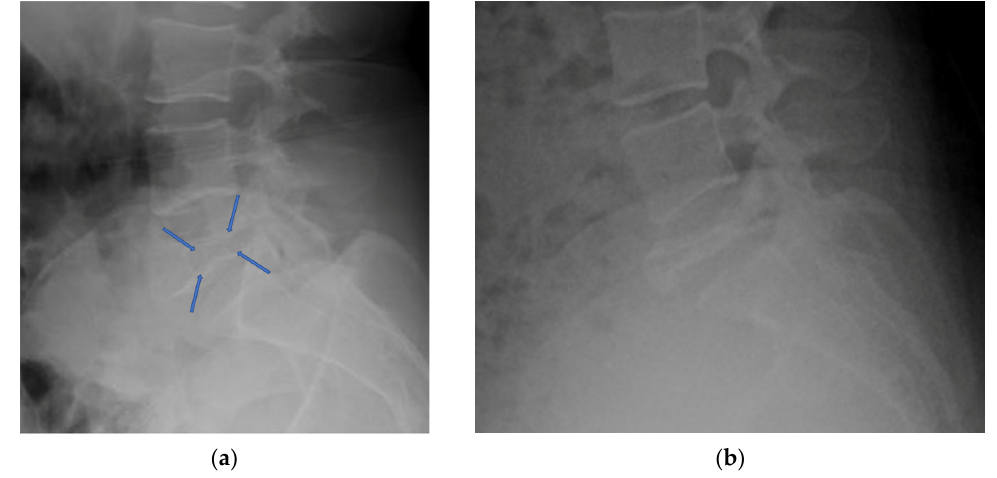
Figure 1. ( a ) Lateral radiograph of a biopsy confirmed L5 Giant Cell Tumor; arrows indicate characteristic soap bubble appearance in the L5 vertebral body with loss of vertebral body height indicating pathologic vertebral body fracture. ( b ) Lateral radiograph of the same L5 Giant Cell Tumor after 6 months of IV denosumab treatment showing consolidation of the tumor.